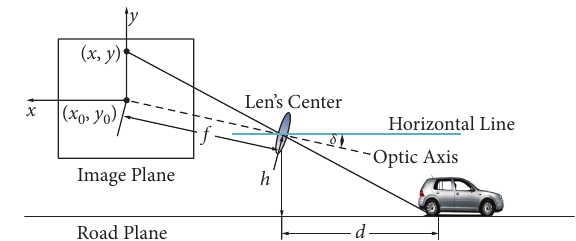
Figure 1: Schematic diagram of pinhole imaging.